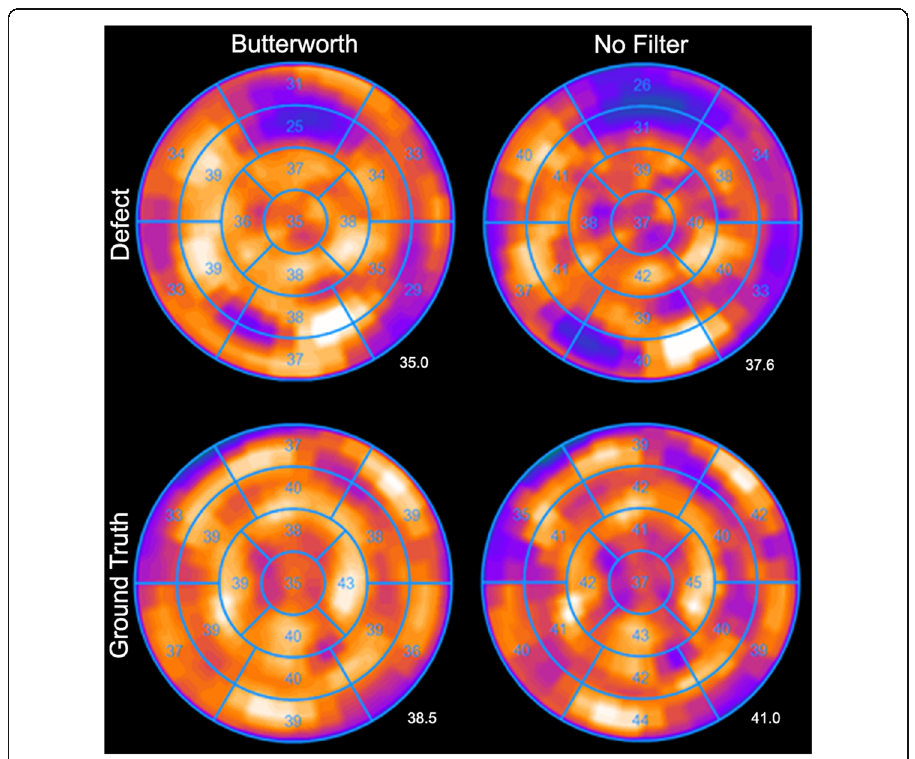
Fig. 4 Bull ’ s eye plots of Butterworth filtered data (left panel) and unfiltered data (right panel). The values are in kBq/mL and depict one acquisition of the S-configuration with the defect in the mid-anterior segment (top) and ground truth (bottom). The number right below the Bull ’ s eye plot concerns the average global tracer uptake in